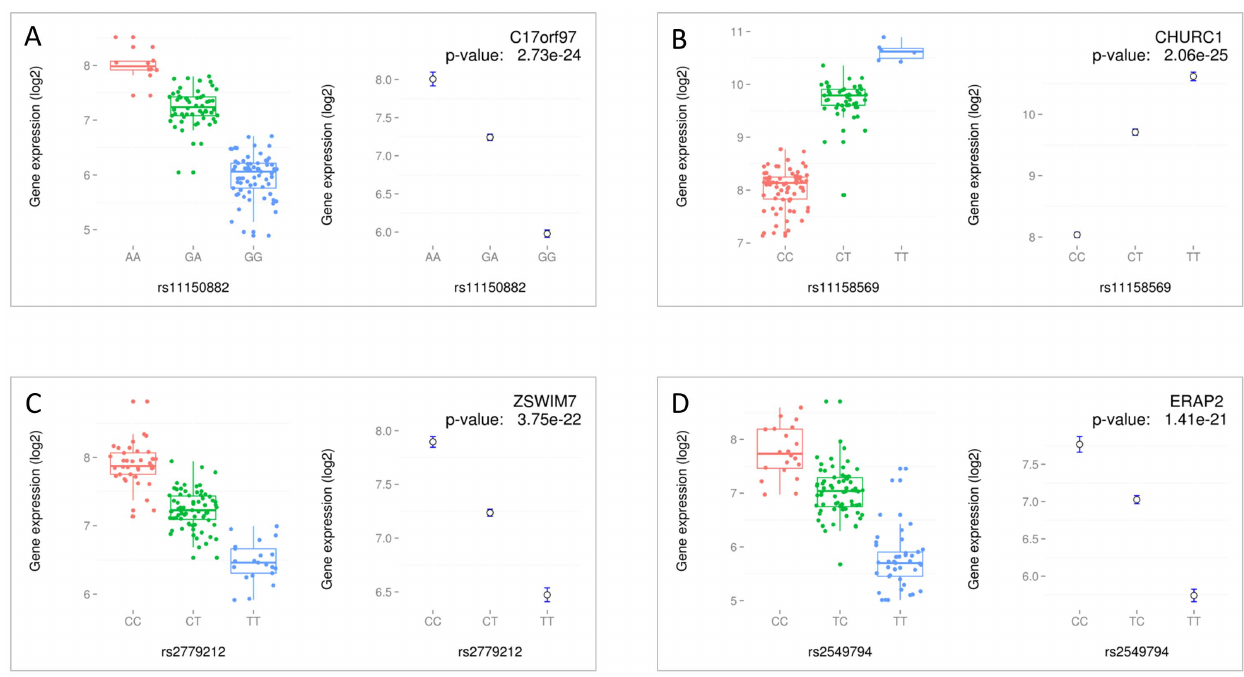
Figure 1. Overview plots for top cis eQTLs. An overview of the 4 most significant cis eQTLs: rs11150882 with C17orf97 (panel A), rs11158569 with CHURC1 (panel B), rs2779212 with ZSWIM7 (panel C) and rs2549794 with ERAP2 (panel D). On the left of each panel, box-and-whisker plots of mRNA levels for all genotypes. On the right, mean and standard-error plots of mRNA levels for all genotypes are illustrated. Right upper corner gives the association p-value and the gene name.